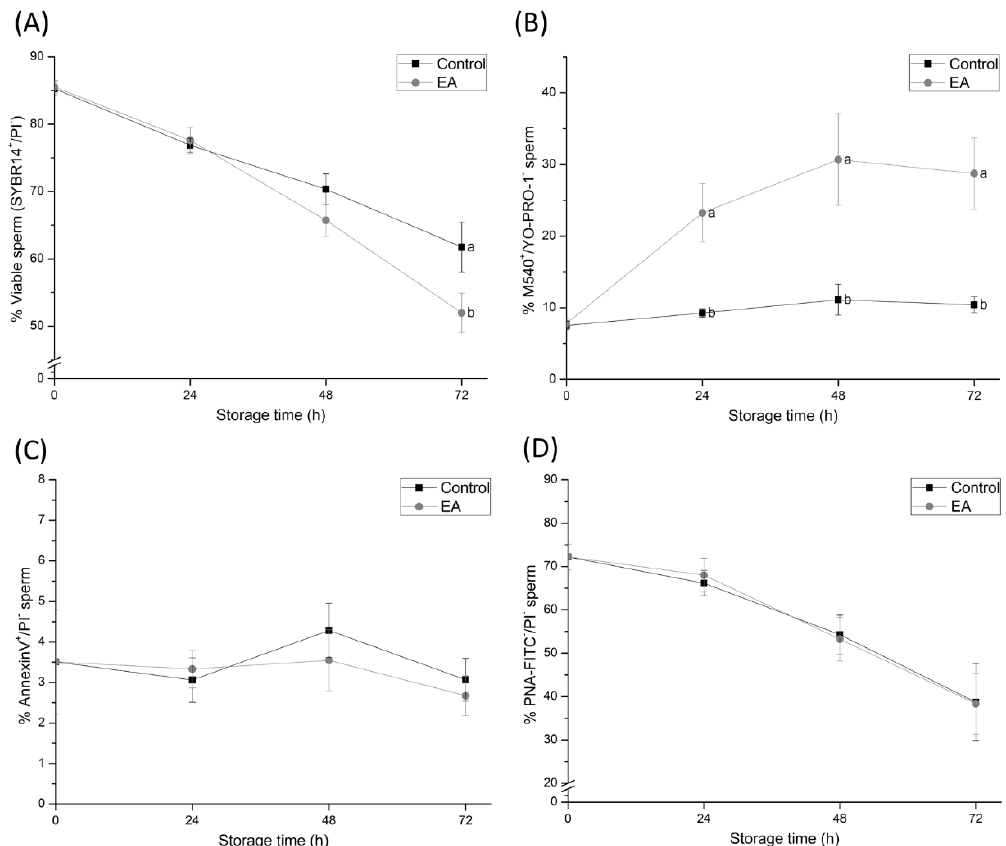
Figure 2. Percentages of ( A ) total viable sperm (SYBR14 + /PI - ), ( B ) viable sperm with high membrane lipid disorder (M540 + /YO-PRO-1 - ), ( C ) viable apoptotic-like sperm (AnnexinV + /PI - ) and ( D ) viable acrosome membrane-intact sperm (PNA-FITC - /PI - ) of semen samples treated with ethacrynic acid (EA), a glutathione S-transferases (GSTs) inhibitor, and the control group, assessed at different evaluation times during liquid storage at 17 °C (0, 24, 48, and 72 h). Different letters (a, b) indicate significant differences ( p < 0.05) between treatments within storage time.